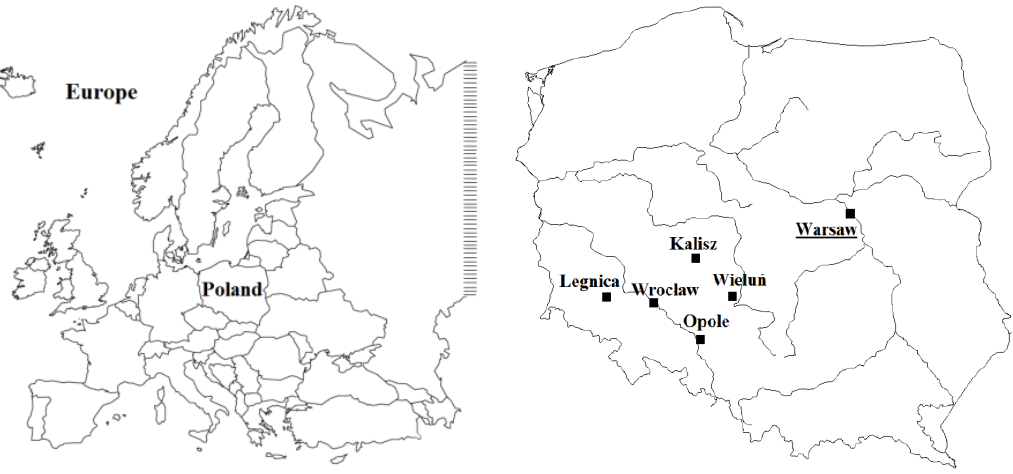
Figure 1. Location of meteorological stations in south-western Poland.